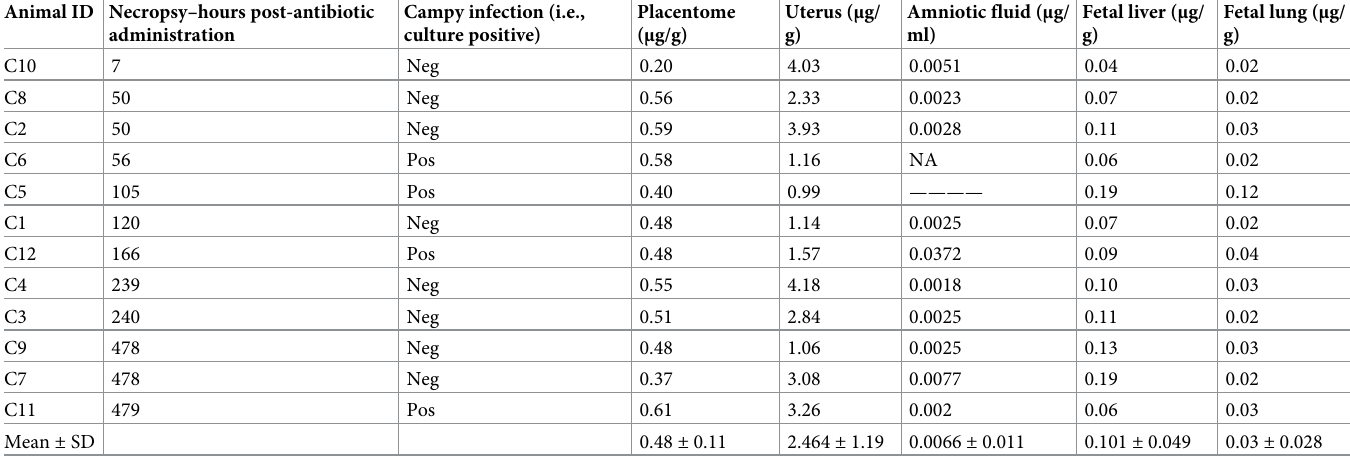
The amniotic fluid results of C5 were not reported because they were a statistical